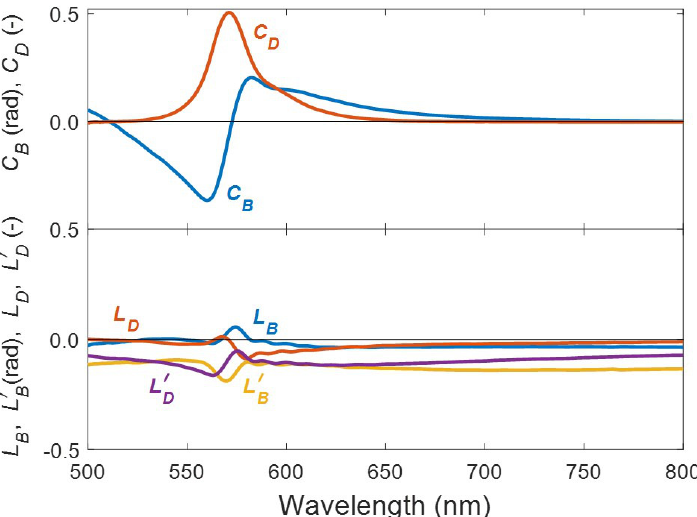
Figure 7. Birefringence and dichroism of the elytron from C. aurata (sample